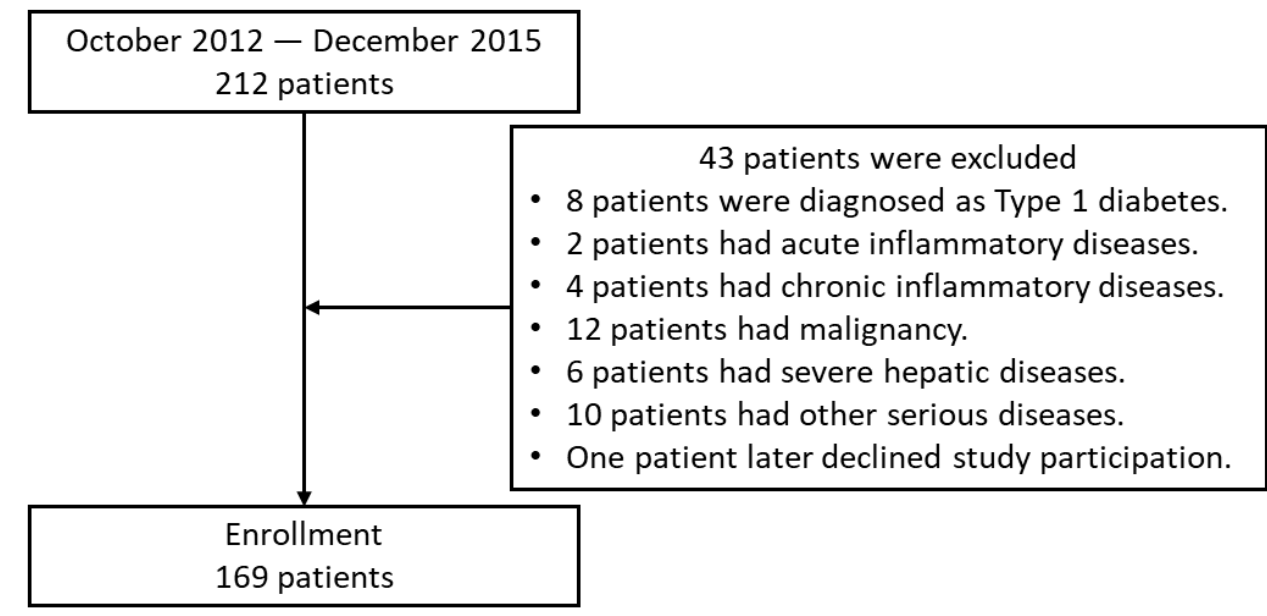
Figure 1. Flow chart of patient enrollment. Table 1. Characteristics of the participants as a whole ( n = 169) and of those with lower (Lo RemL- C (<0.24 mmol/L): n = 83) or higher (Hi RemL- C (≥0.24 mmol/L): n = 86) RemL-C concentrations.